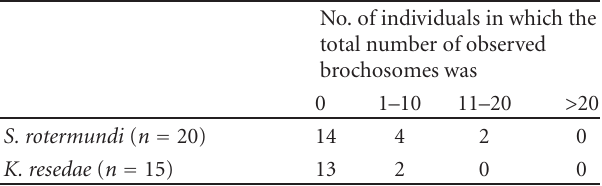
Table 1: Distribution of the total number of brochosomes observed per individual among adults of two heteropteran species reared in